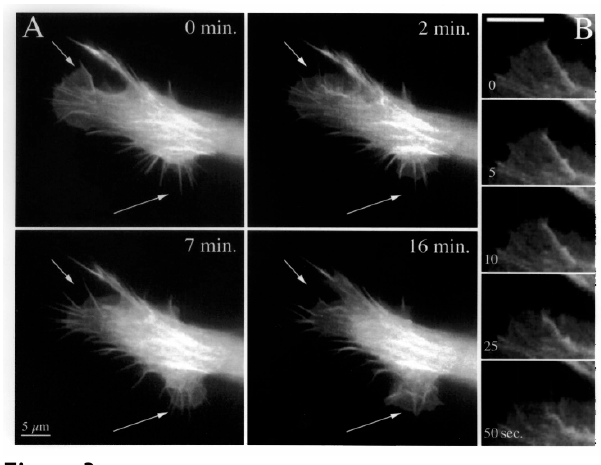
Figure 3 The distribution of C-moesin-GFP parallels dynamic changes in the actin cytoskeleton. In (A), a live, fluorescent cell was imaged for 16 minutes. Note retraction of a lamellipodium (top arrow) and advance of another (lower arrow), as the cell changes direction and begins to migrate towards the bot- tom of the page. The retracting lamellipodium from (A) is shown at higher magnification and temporal resolution in (B). The fifty second sequence starts after the first panel of (A) and ends before the second panel. Note kinking, buckling and withdrawal of a rib-like microfilament bundle within the lamella. See also three related movie files (Additional Mate-